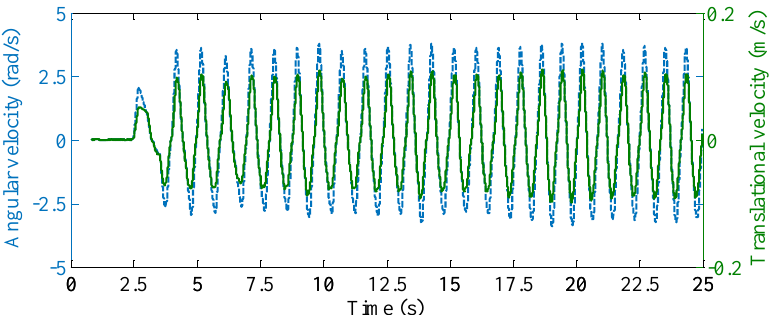
Figure 11. Calculated rotational angular velocity (dotted line) and translational velocity (solid line) of Link 2. Note the translational velocity has been smoothed by a moving window with a width of 2001 data points.